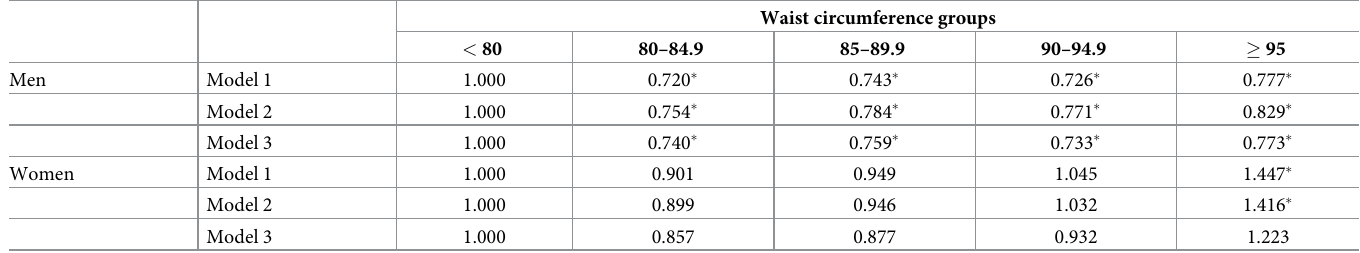
Table 2. Hazard ratio for overall mortality according to waist circumference